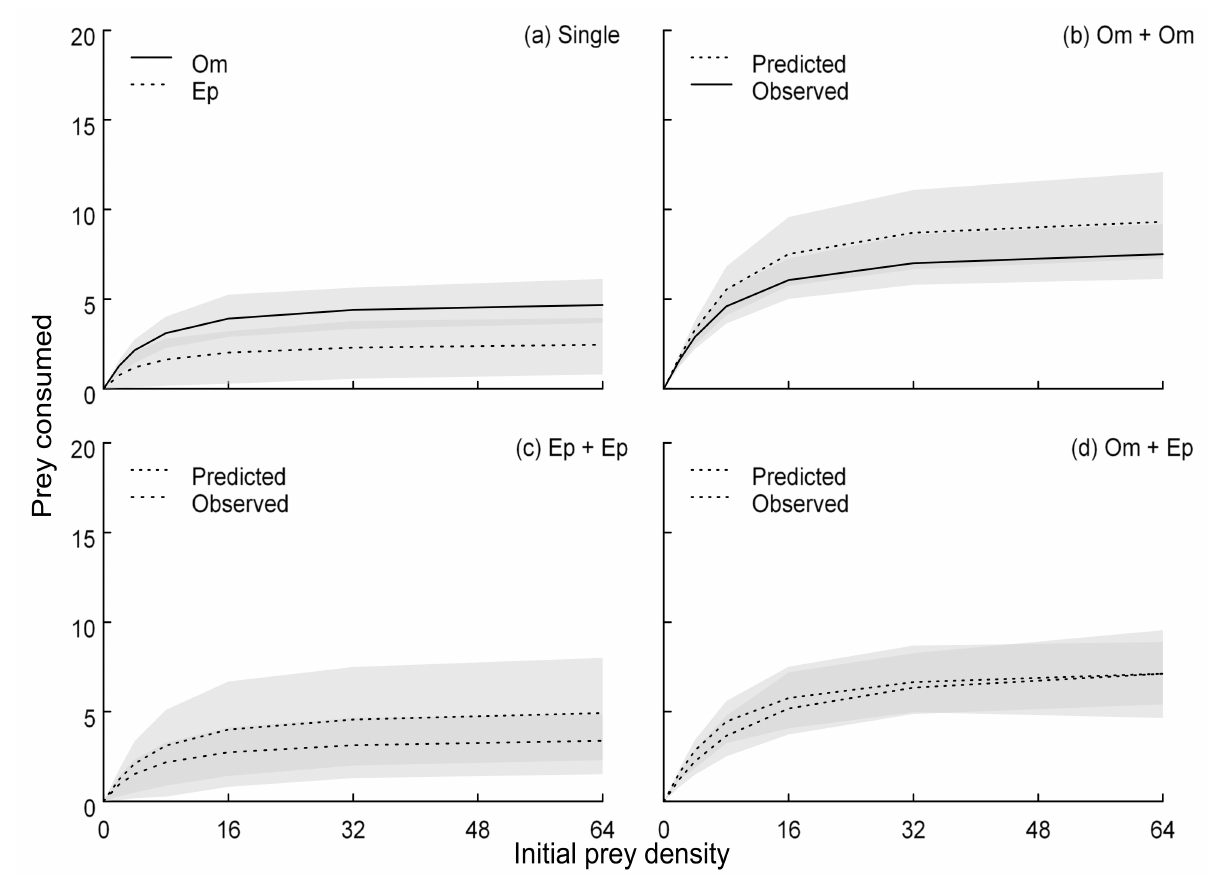
Figure 3. Functional responses of Oreochromis mossambicus (Om) and Enteromius paludinosus (Ep). As single predators ( a ) and in pairs ( b – d ). Observations correspond to experimental data from paired predator groups, whilst predictions in each panel were modelled from functional responses in single predator groups ( a ) using a population dynamic approach. Shaded areas are 95% confidence